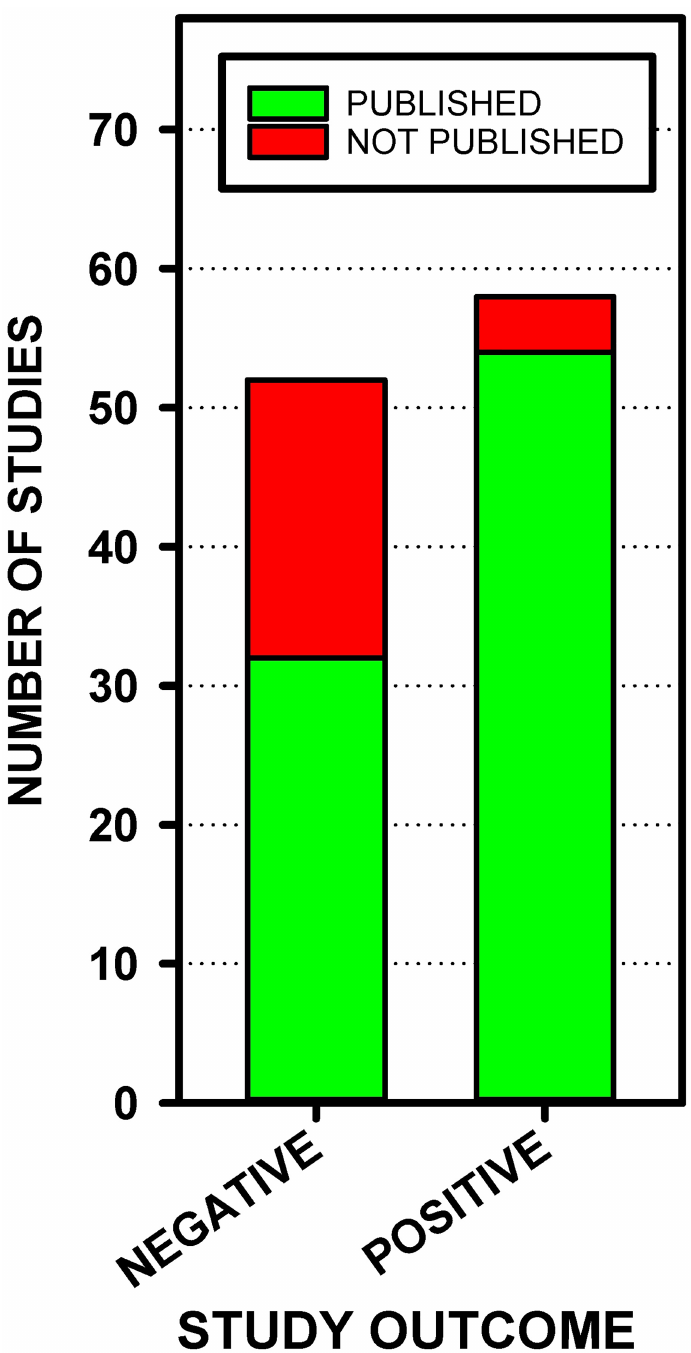
Fig 3. Number of studies published and not published with positive or negative